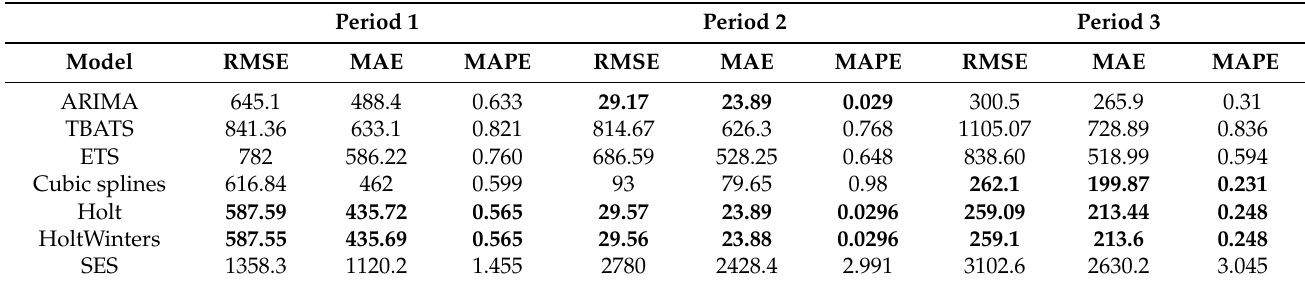
Figure 9. Forecast confirmed cases in Riyadh projected under each model and forecasting period. Black line represents observed confirmed cases. Table 6. Performance of proposed models to predict confirmed Riyadh cases. The best accuracy values are shown in